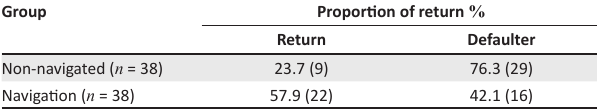
TABLE 3: Proportion of return in navigated and non-navigated